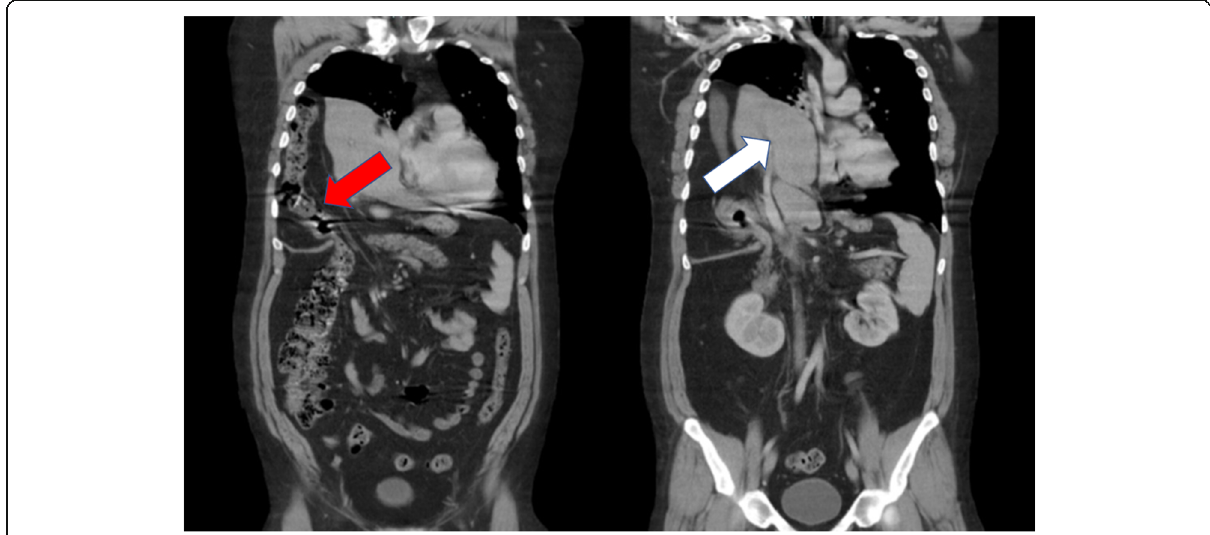
Fig. 3 Coronal chest/abdominal/pelvis CT showing massive thoracic displacement of intraabdominal organs. In the left image, a loop of the colon can clearly be seen entering the thoracic cavity through the defect (red arrow). In the right image, the entire mass of the liver can be seen in the thoracic cavity with the hepatic vasculature extending across the diaphragmatic defect (white